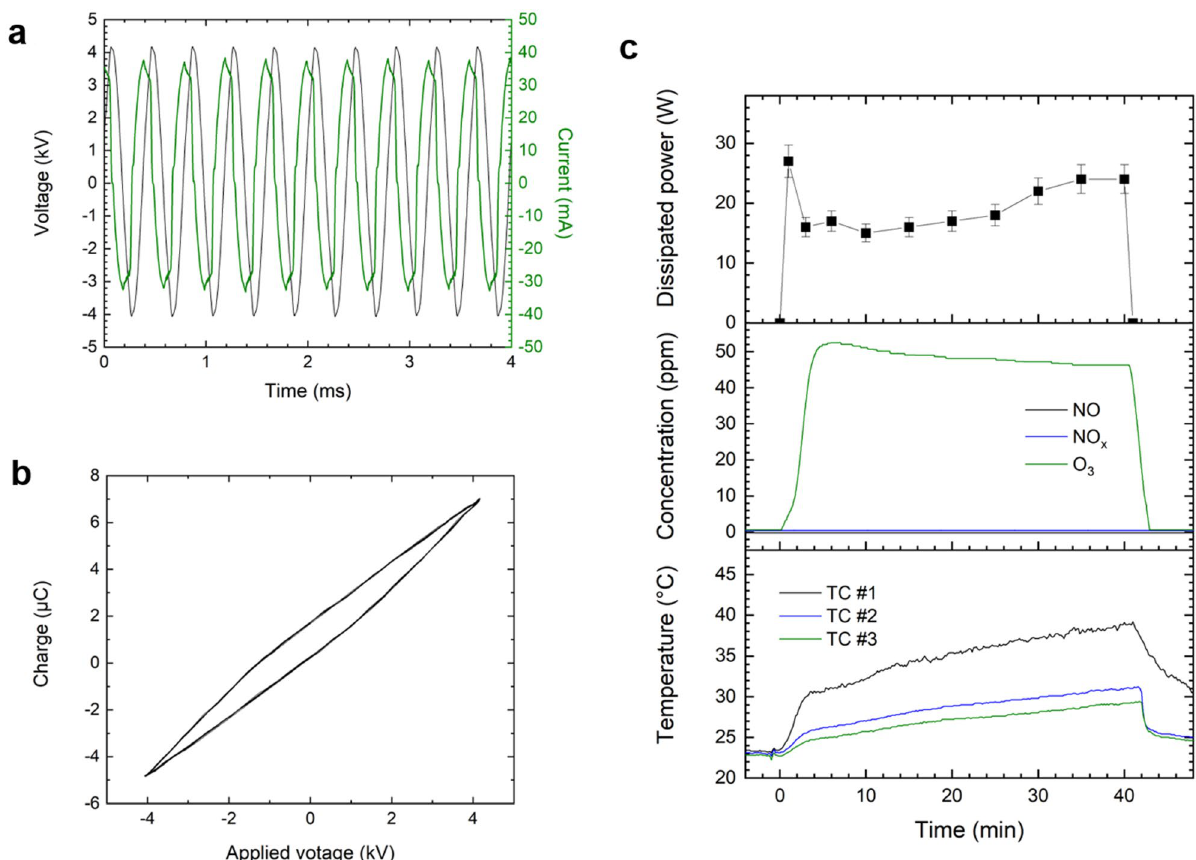
Figure 2. Characteristics of the plasma apparatus based on a SDBD electrode: ( a ) Voltage and current waveform applied to four SDBD electrodes, ( b ) Lissajous figure, and ( c ) time evolution of the dissipation power, concentrations of NO x and O 3 generated by the plasma, and gas temperatures inside the processing